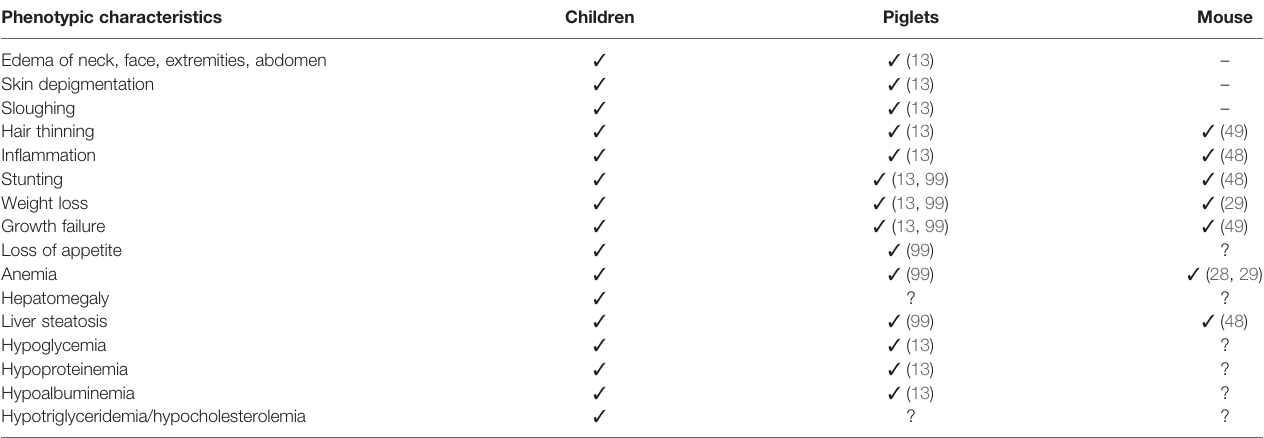
TABLE 2 | Clinical parameters of kwashiorkor in children, piglets, and